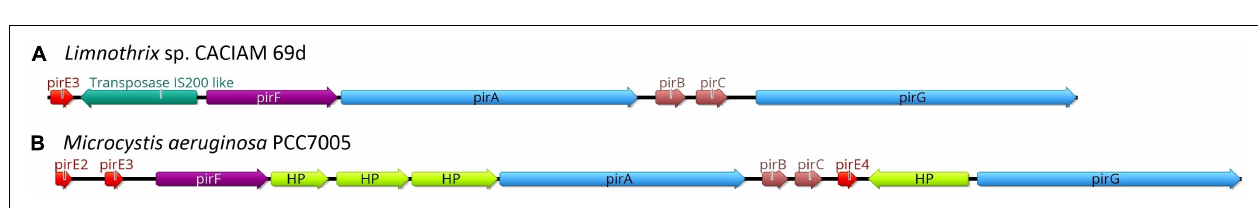
FIGURE 7 | Schematic showing TCA cycle and nitrogen acquisition pathways in Limnothrix . The dotted boxes delimit carbon (black) and nitrogen (green) metabolisms. Compounds are represented by circles and their respective names indicated in black. Arrows indicate reactions; enzyme reactions are shown in red, transport reactions in orange and a spontaneous KEGG reaction is shown in purple. The green reaction occurs exclusively in Limnothrix rosea IAM M-220 NIES-208. ACO, aconitase; ArgD, γ -aminobutyric acid aminotransferase; CA, carbonic anhydrase; CL, cyanate lyase; CS, citrate synthase; FUM, fumarase; GadA, glutamate decarboxylase; GdhA, glutamate dehydrogenase; GlnA, glutamine synthase; GS, glutamine synthase; IDH, isocitrate dehydrogenase; MDH, malate dehydrogenase; ME, malic enzyme; 2-OGDC, 2-oxoglutarate decarboxylase; PDC, pyruvate dehydrogenase complex; PEP, phosphoenolpyruvate; PEPC, phosphoenolpyruvate carboxylase; PK, pyruvate kinase; SDH, succinate dehydrogenase; SSADH, succinic semialdehyde dehydrogenase.